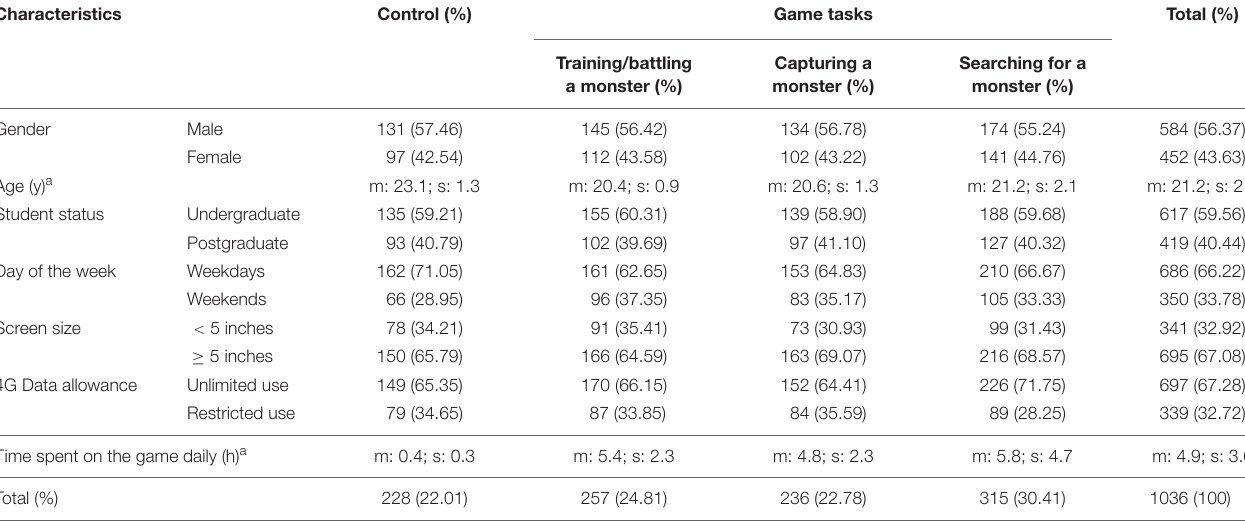
TABLE 1 | Distribution of various types of game tasks according to independent variables ( N =